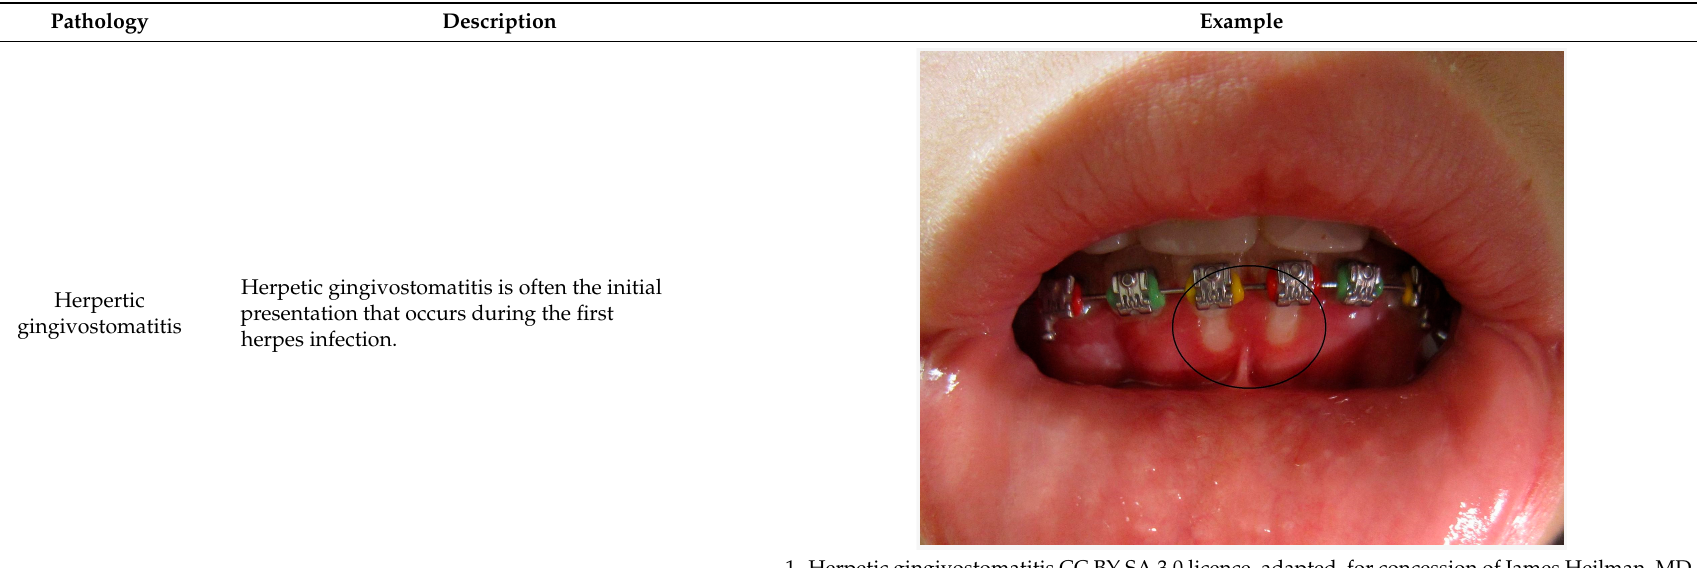
Figure 1. Herpetic gingivostomatitis CC BY-SA 3.0 licence, adapted, for concession of James Heilman, MD